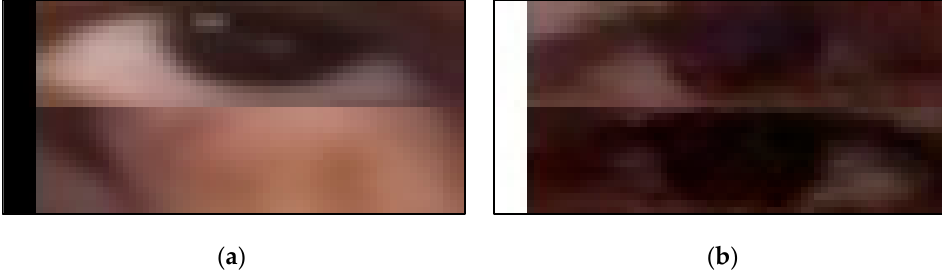
Figure 12. The remake fusion image with eye image and gender signal: ( a ) the eye image with male signal and ( b ) the eye image with the female gender.